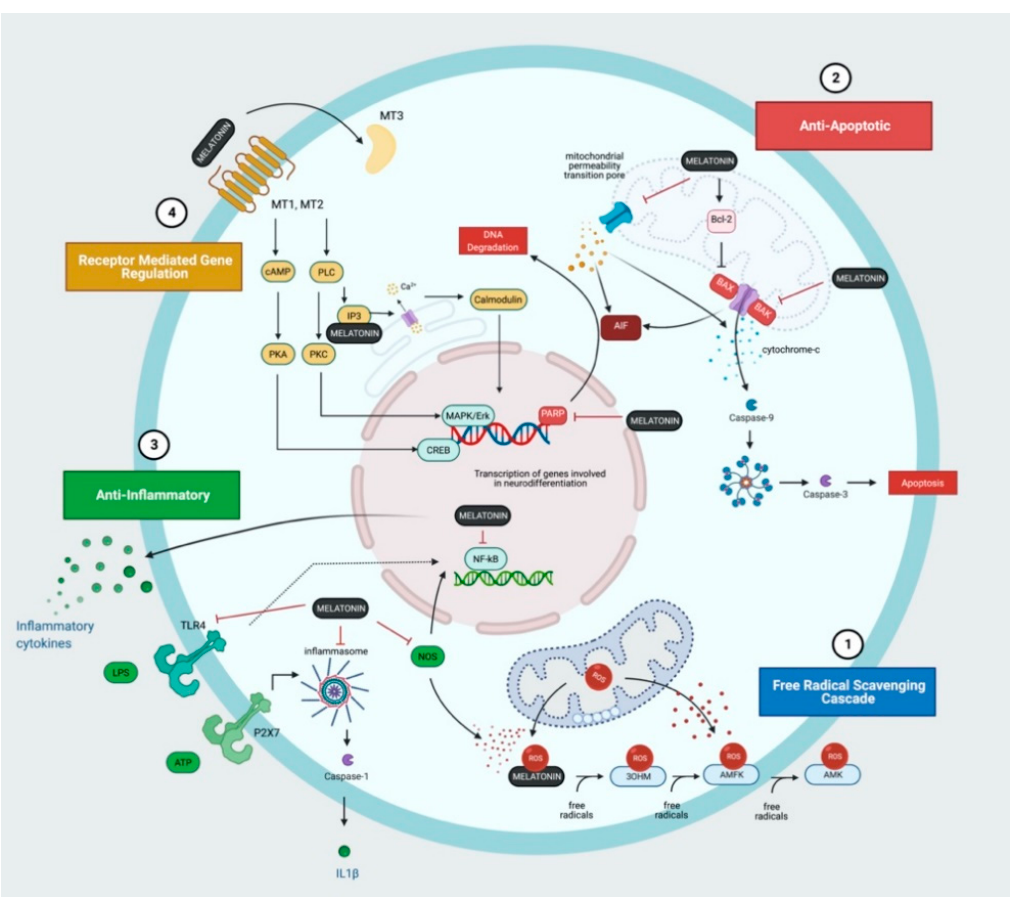
Figure 2. Melatonin and the Molecular Mechanisms of Action. (1) Melatonin and its metabolites; 3-hydroxymelatonin (3OHM), N1-acetyl-N2-formyl-5-methoxykynuramine (AFMK) and N1-acetyl-5-methoxykynuramine (AMK) form a potent free radical scavenging artillery that removes reactive oxygen species (ROS) and other free radicals produced following hypoxia-ischaemia. (2) Melatonin inhibits pro-apoptotic proteins (BAX), prevents the opening of the mitochondrial permeability transition pore and inhibits the poly(ADP-ribose) polymerase (PARP)-dependent cell death pathway. (3) Melatonin exhibits anti-inflammatory properties through the inhibition of nitrogen oxide synthase and Toll-like receptor 4 (TLR4) expression thereby suppressing inflammatory cytokine and chemokine production. (4) Melatonin also acts through receptors (MT1, MT2, MT3) to regulate a diverse range of downstream targets contributing to neuroprotection.